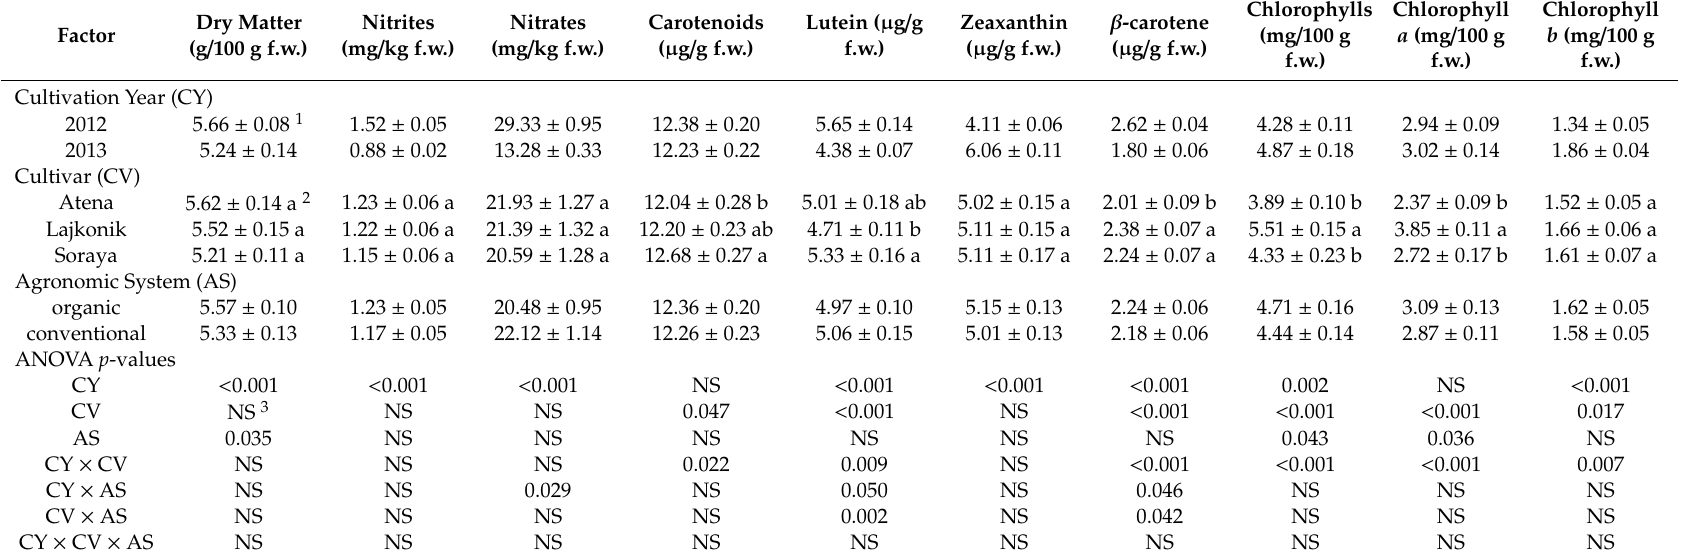
Table 3. The main e ff ects of, and interactions between, cultivation year, cultivar and agronomic system on the content of dry matter, nitrites, nitrates, carotenoids and chlorophylls in the courgette